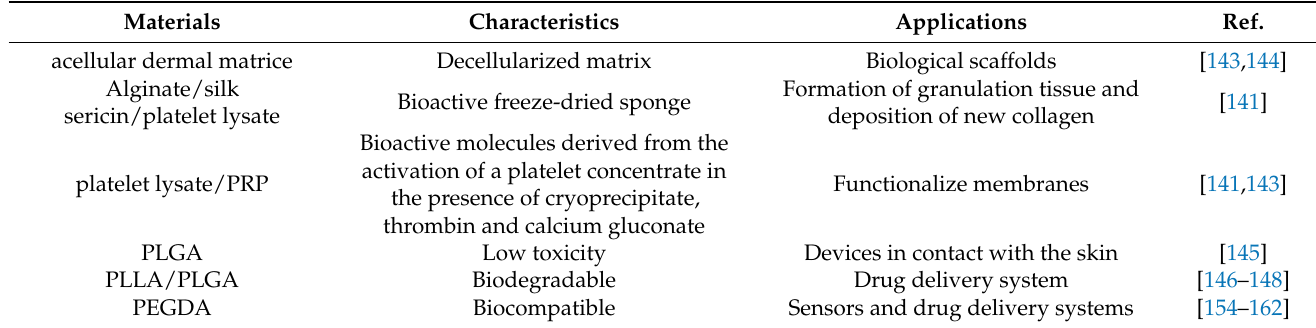
Table 5. Characteristics and applications of biomaterials on skin